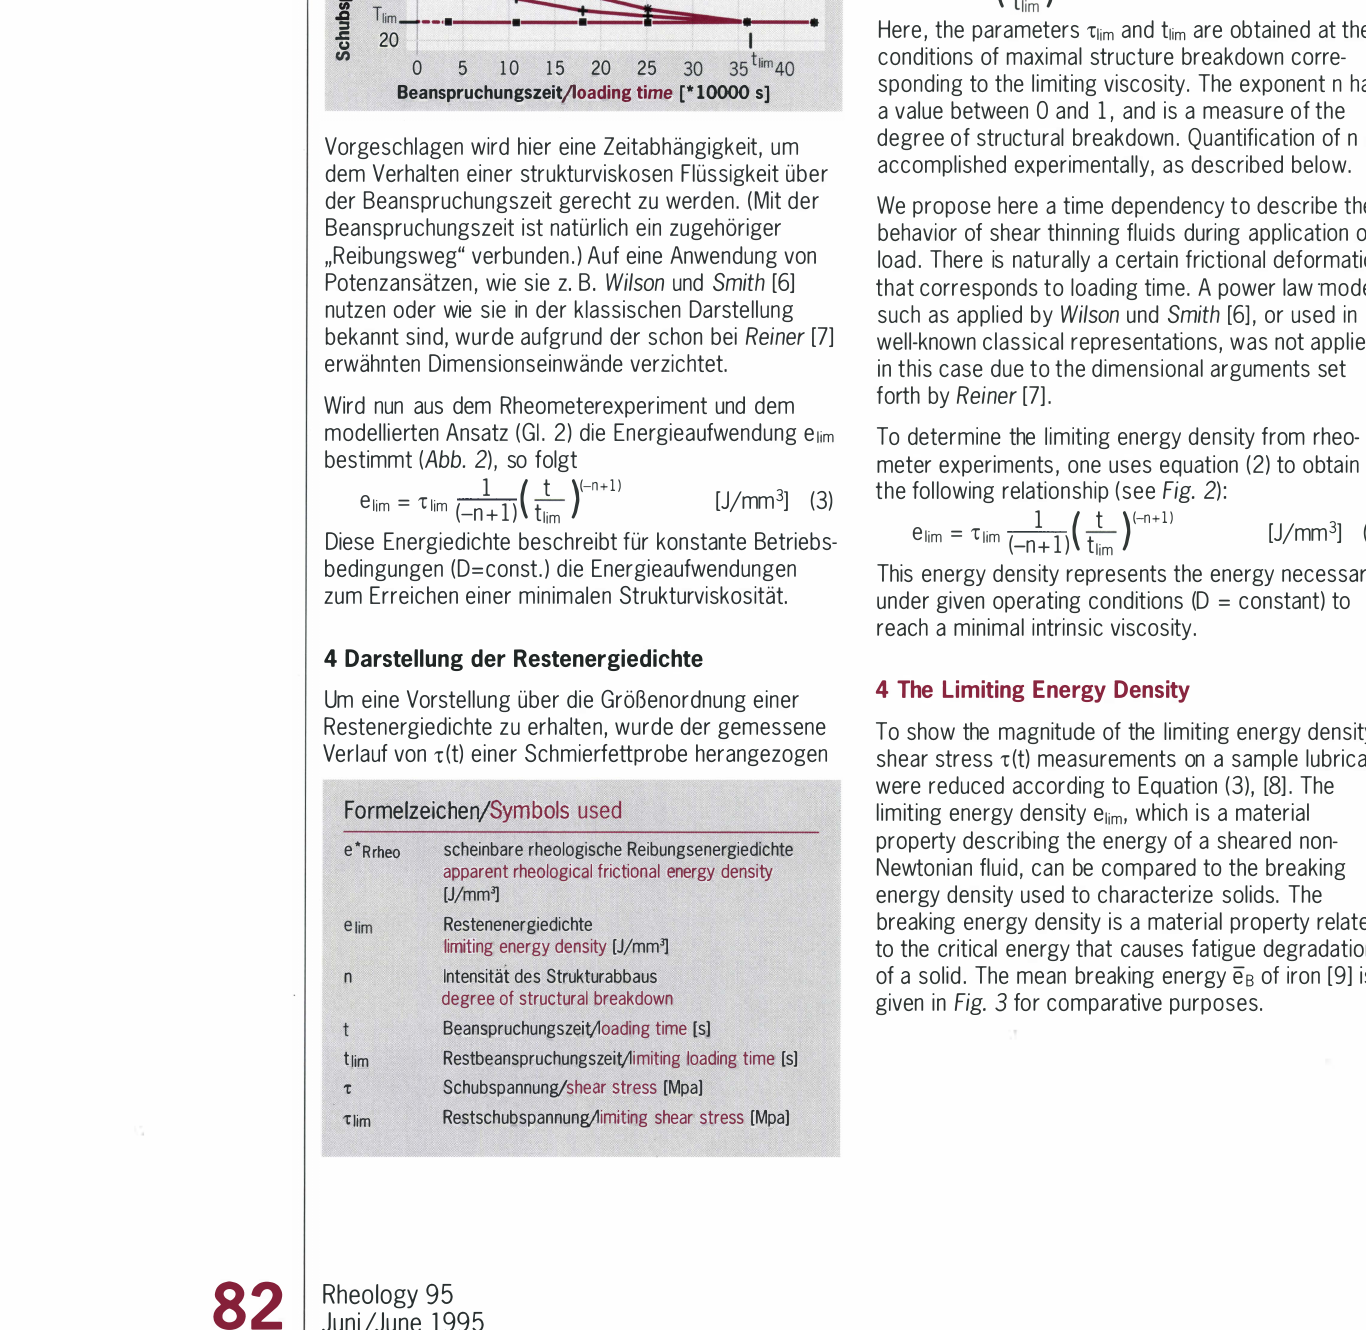
Abb. 2: Modelliertes Verhalten der Schubspannung (Beispiel) Fig. 2: Modeled behavior of the shear stress